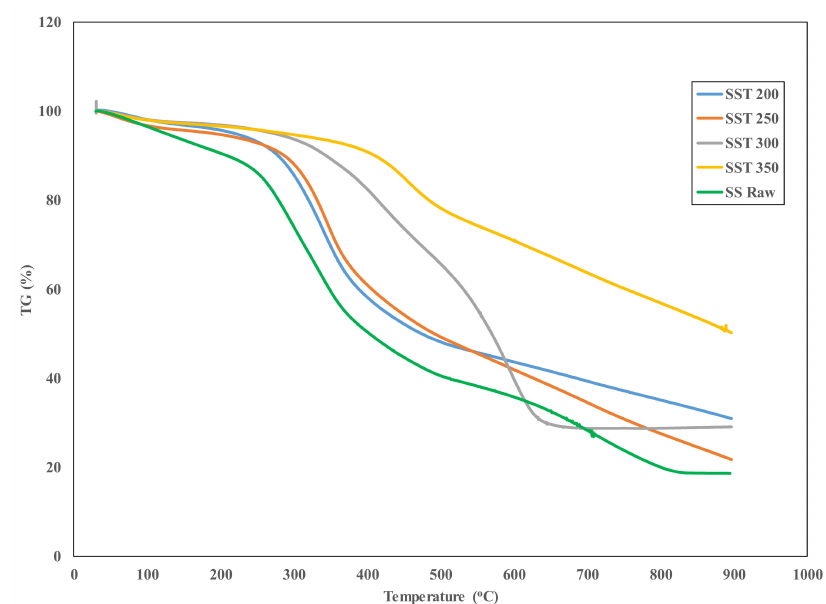
Figure 1. TG curves for raw and torrefied sewage sludge at heating 25 ◦ C/min (SST 200—sewage sludge torrefied at 200 ◦ C, SST 250—sewage sludge torrefied at 250 ◦ C, SST 300—sewage sludge torrefied at 300 ◦ C, SST 350—sewage sludge torrefied at 350 ◦ C, and SS Raw—raw sewage sludge).